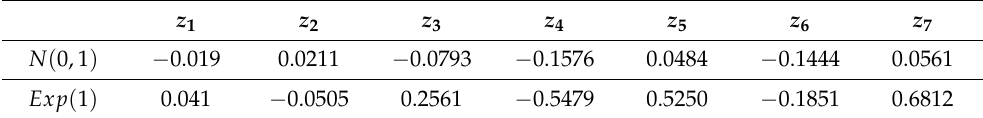
Figure 2. Cumulative density function obtained by collocation in the first example.